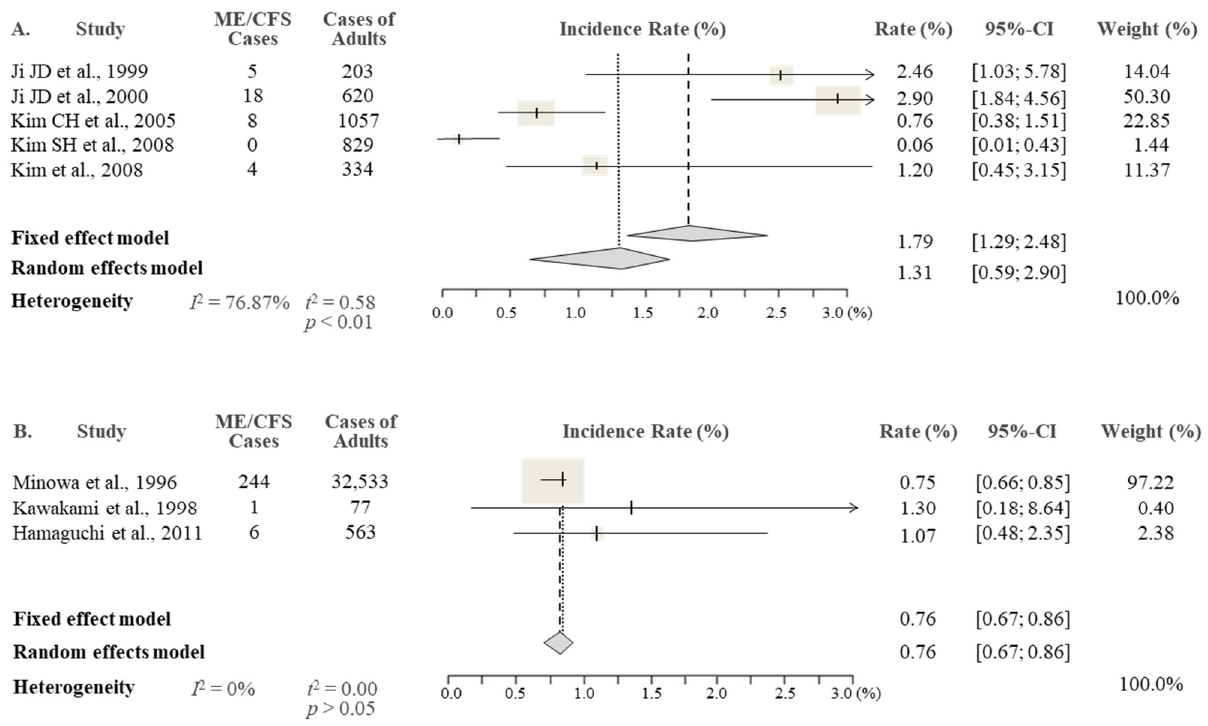
Figure 4. Meta-analysis of the ME/CFS prevalence in females in Korea ( A ) and Japan ( B ).